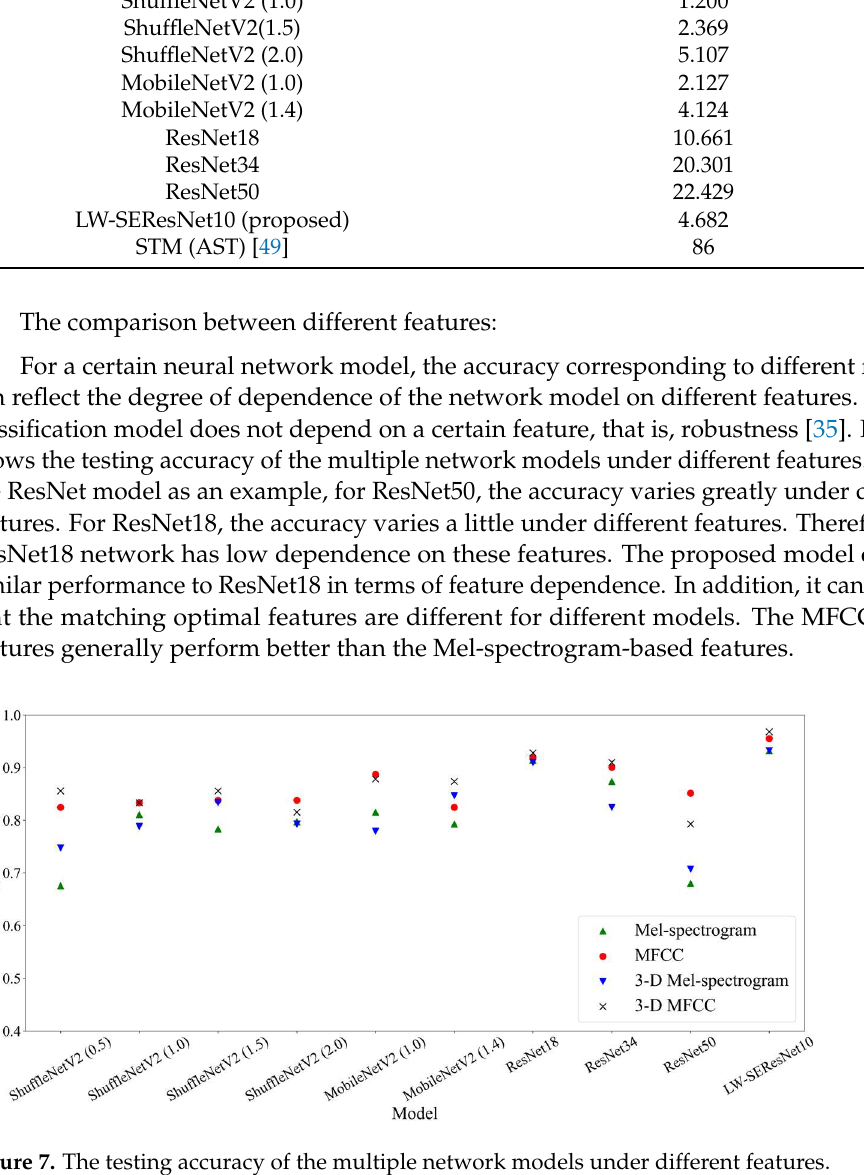
Table 7. The number of parameters of multiple models.